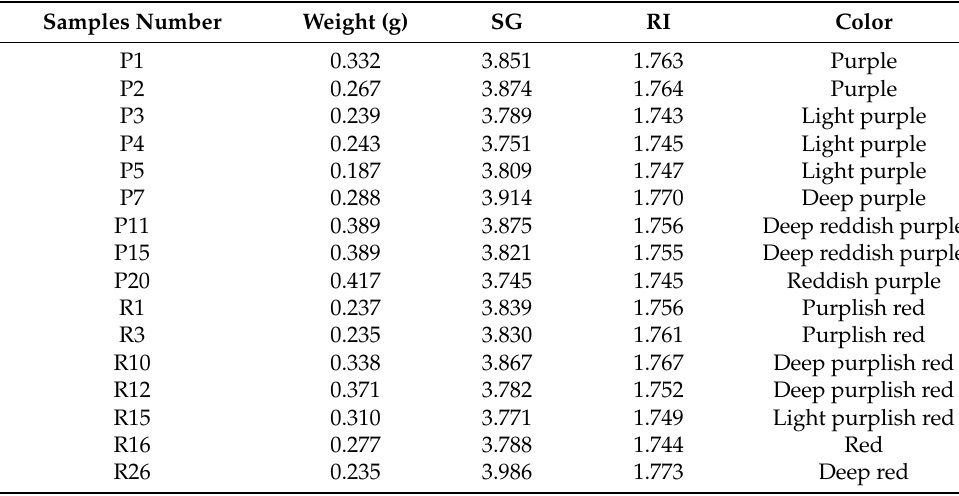
Figure 2. Violet to red pyrope-almandine which differ from the hue, chroma, and lightness. Table 1. standard gemological characteristics of the samples.